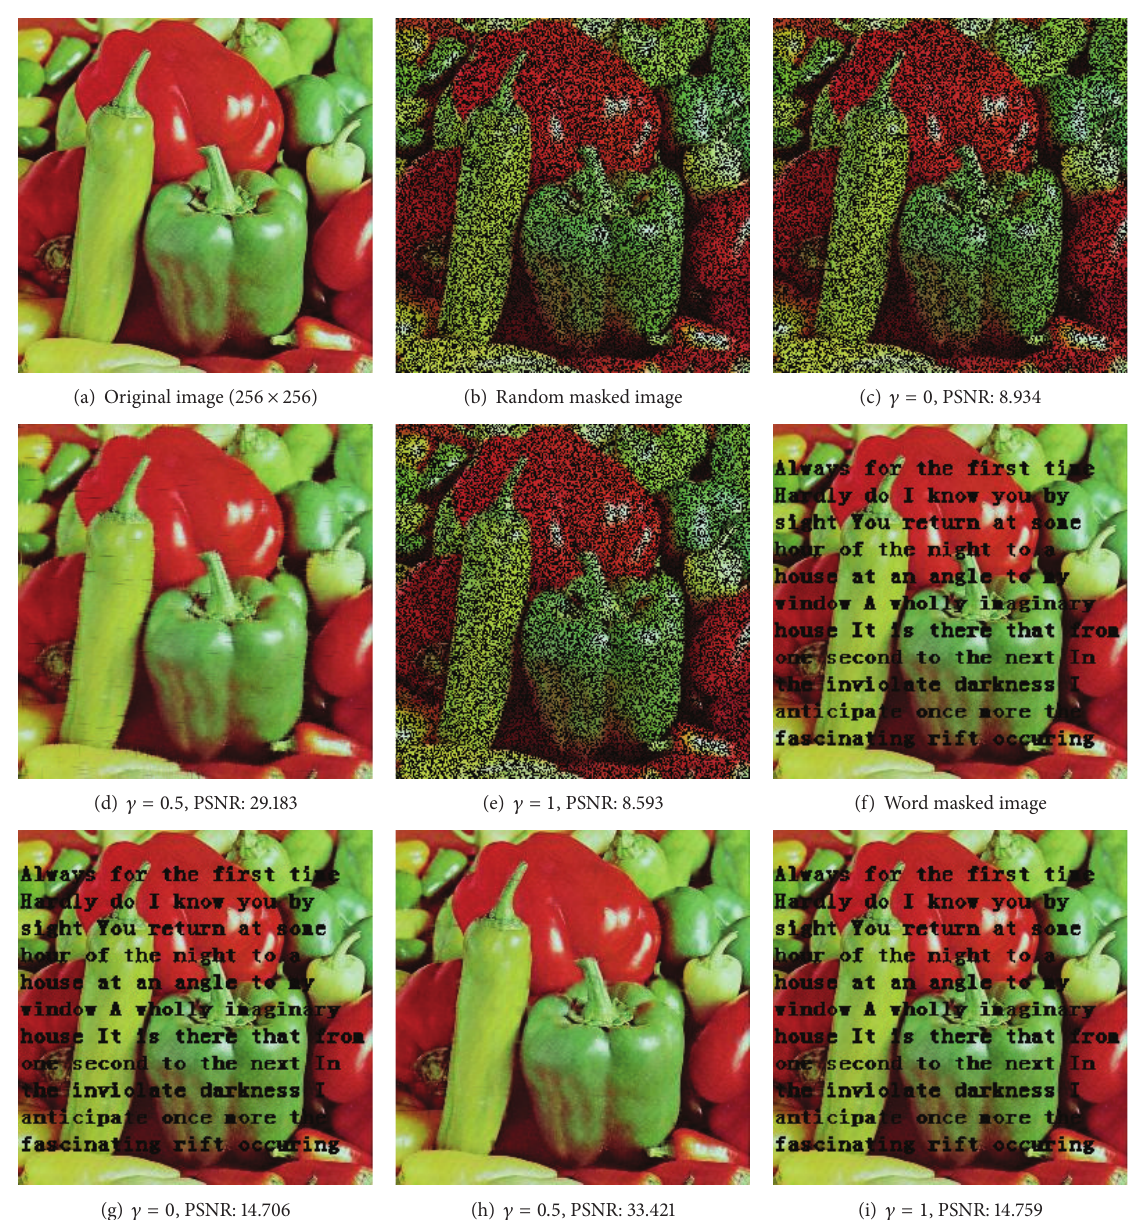
Figure 1: The recovered results with 60% random mask and word mask for 𝛾 = 0 , 0.5 and 1 by